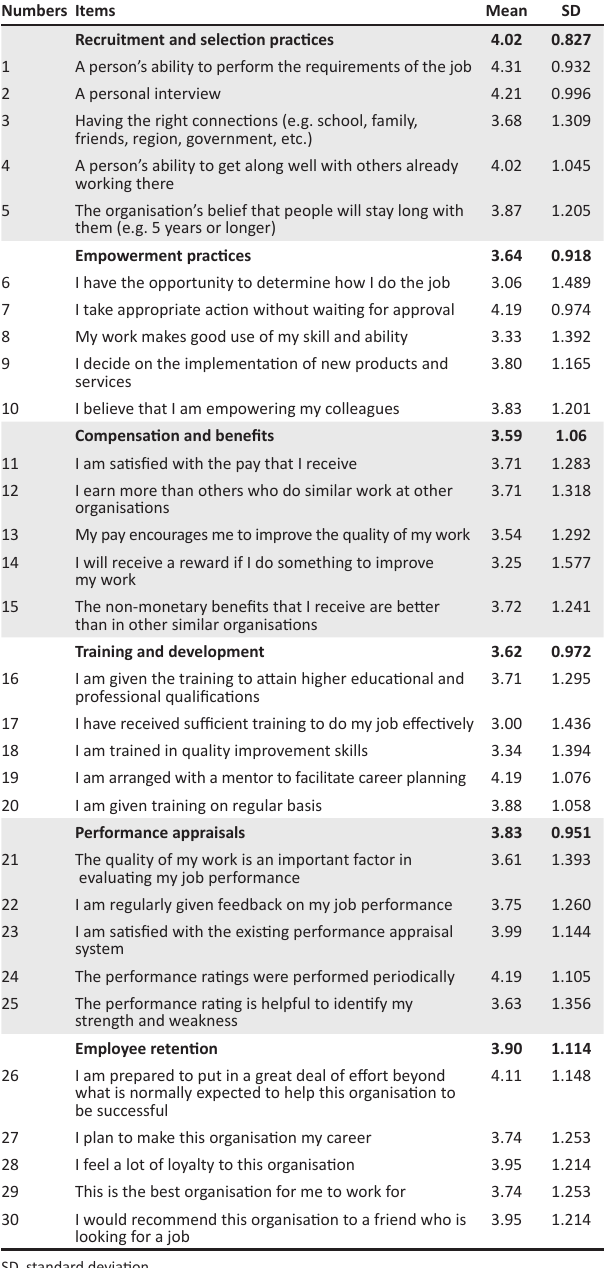
TABLE 3: Results of descriptive statistics of items and Cronbach’s alpha results (DV: Employee retention). Numbers Items